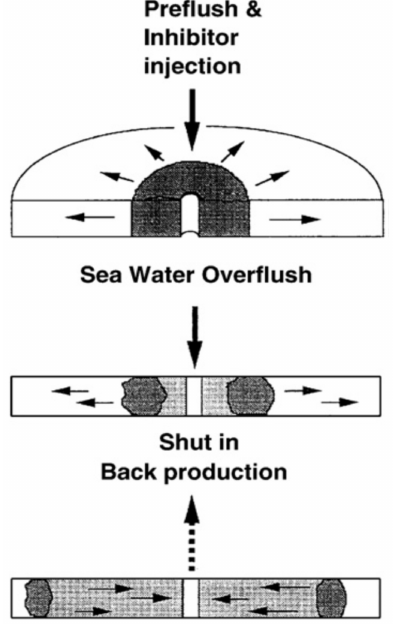
Figure 6. Schematic view of scale treatment procedure [78].